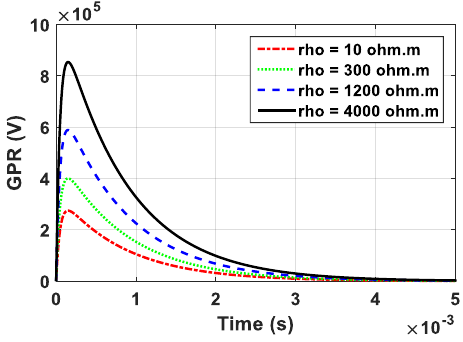
Figure 15. GPR of a simple grounding grid.